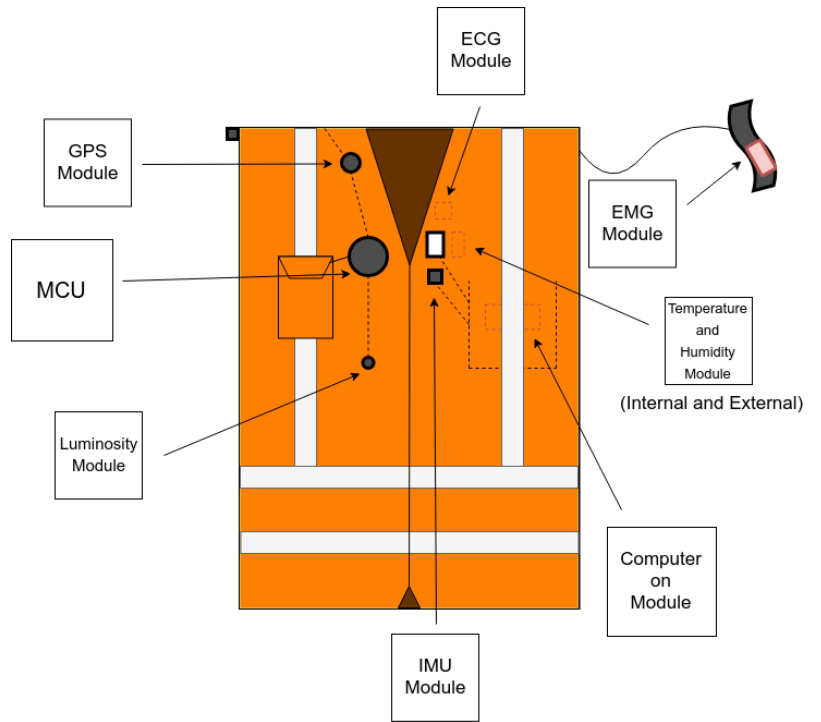
Figure 4. Wearable device